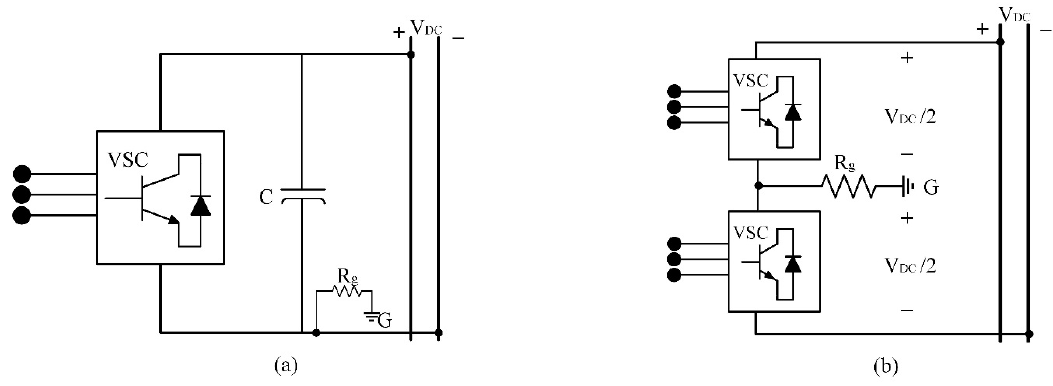
Figure 9. Grounding methods of DC power systems [61]. Figure 9. Earthing methods of DC power systems [59]; ( a ) Monopole Earthing; ( b ) Neutral-Point